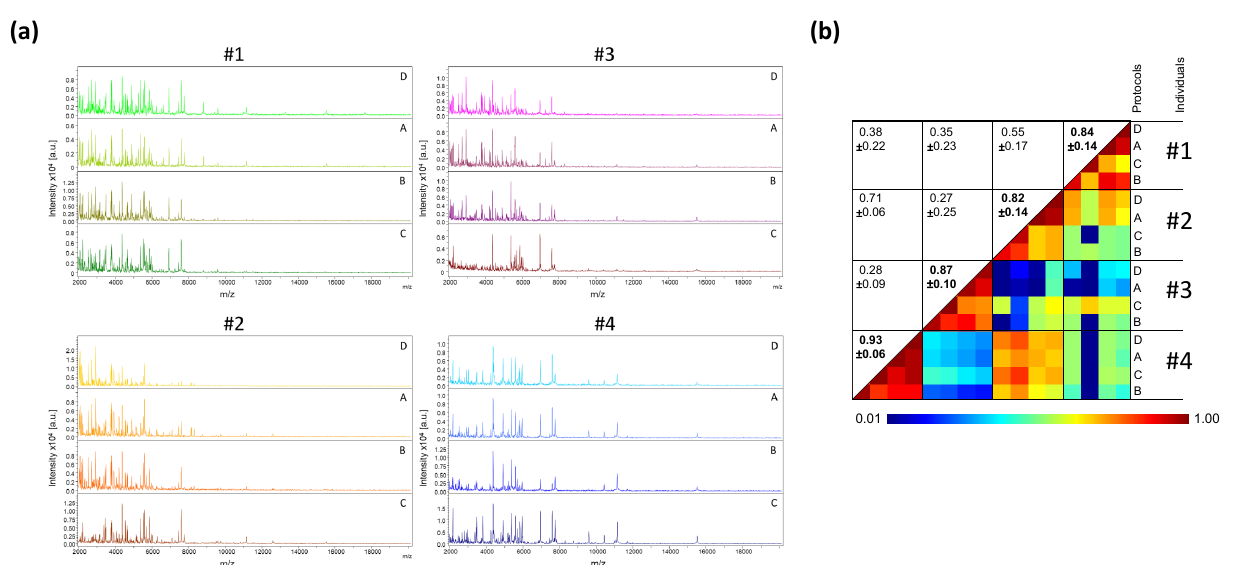
Figure 1. Comparison of MALDI-TOF MS profiles from saliva samples pre-treated with distinct protocols. ( a ) Representative MS spectra from saliva, collected in plastic tube, of four healthcare workers (#1 to #4) per condition of preparation (protocols A to D). a.u., arbitrary units; m / z , mass-to-charge ratio. ( b ) Assessment of saliva spectra reproducibility for sample pre-treated with distinct protocols using composite correlation index (CCI). The levels of MS spectra reproducibility are indicated in red and blue, revealing relatedness and incongruence between spectra, respectively. CCI are expressed as the mean ± standard deviation. CCI-values per individuals among the different protocols were indicated in bold. A: Saliva diluted with 1 vol. of water; B: A + 1 vol. of Mix buffer; C: 100 µ L of A + 400 µ L absolute ethanol at − 20 ◦ C overnight (ON), centrifugation and pellet re-suspended with 100 µ L of Mix Buffer; D: 100 µ L of A + 400 µ L ACN at − 20 ◦ C ON, centrifugation and pellet re-suspended with 100 µ L of Mix Buffer. #1–4: healthcare workers.